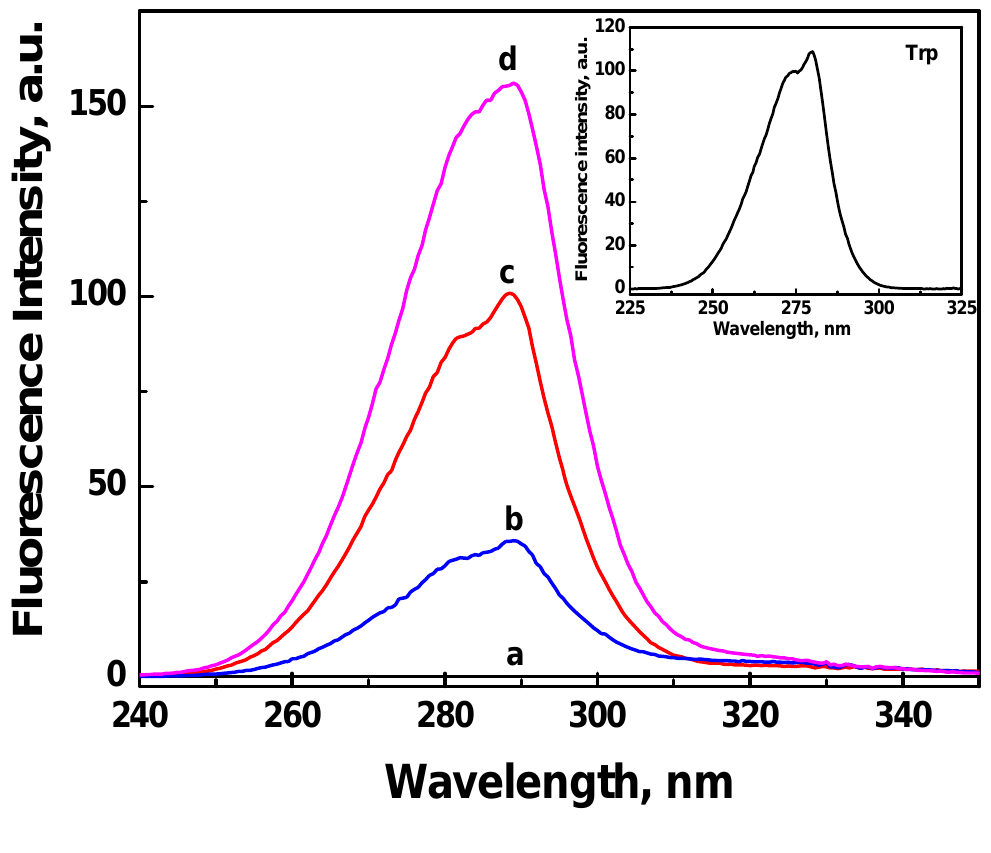
Figure 4. Fluorescence excitation spectra of aqueous suspension of ONC: ( a ) alone, and coupled with: ( b ) Trp-EMP, ( c ) Trp and ( d ) Trp-WRF. The insert shows the excitation spectrum of an aqueous solution of Trp. The emission was monitored at 375